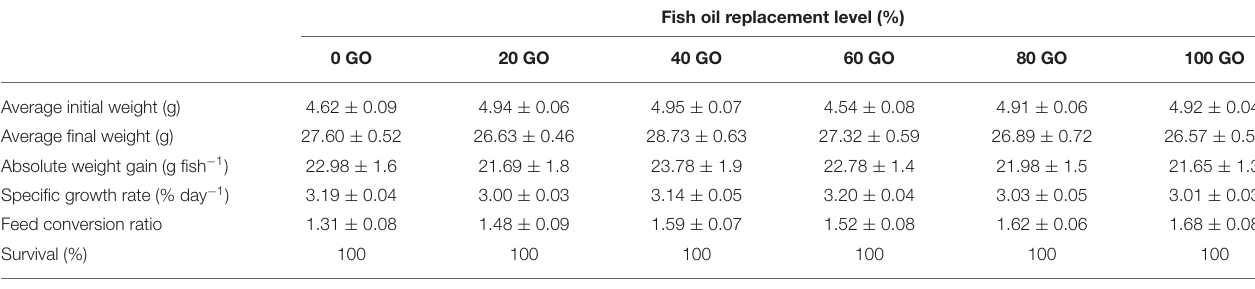
TABLE 3 | Growth performance of fingerling Labeo rohita fed different experimental diets * .